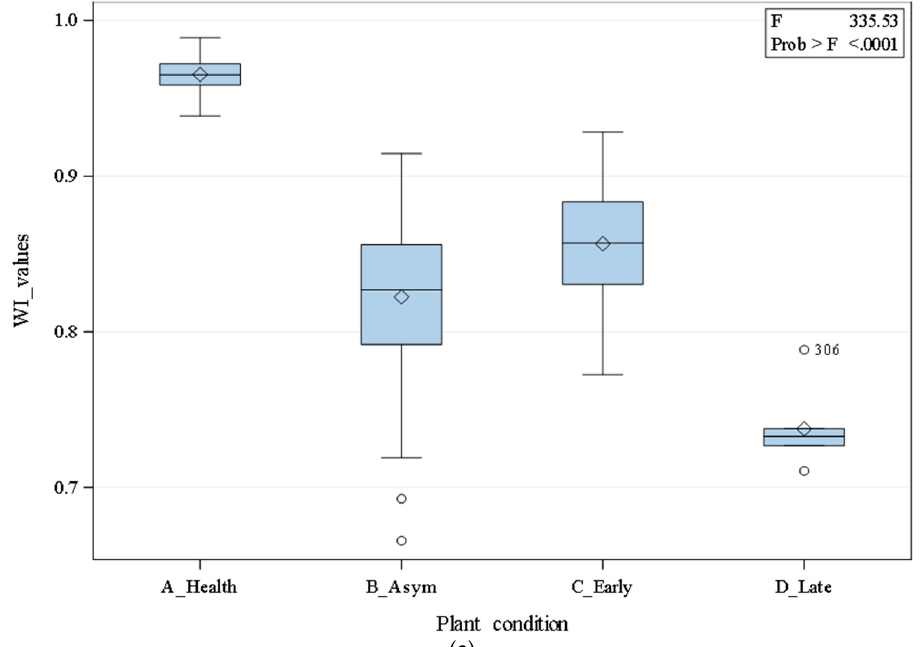
Figure 10. Classification accuracy of the VIs using the RBF method to detect citrus canker. VIs that were able to detect the canker on leaves of ( a ) healthy vs. asymptomatic stage (indoors), ( b ) healthy vs. early stage (indoors), ( c ) healthy vs. late stage (indoors), and ( d ) healthy vs. canker-infected trees using the UAV-based imaging technique (outdoor) are shown.